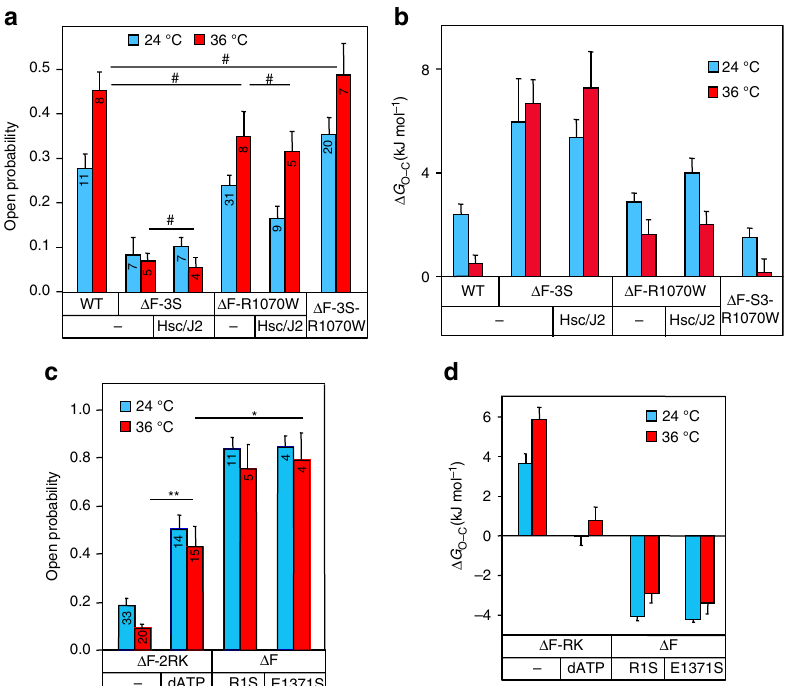
Fig. 7 Chaperoning of Δ F508-CFTR unfolding is altered by second site mutations in the BLM. a , b The in fl uence of second site suppressor mutations (3S, R1070W and 3S + R1070W) and Hsc70/DNAJA2 (Hsc/J2) activity on the P o a and Δ G O – C b of the Δ F508-CFTR-3HA at 24 and 36 °C in BLM. The P o and Δ G – NBD2 dimer was accomplished by R1S, E1371S mutations, or by the O were measured as in Figs. 3 and 4. c , d Stabilization of NBD1 and/or NBD1 inclusion of 2 ʹ -deoxyadenosine 5 ʹ -triphosphate (dATP, 2 mM). The Gibbs free energy of opening was calculated based on the Δ G O – C = − RT(ln K e ) equation. Representative records are shown in Supplementary Fig. 7a, b, d – f. The reconstituted channels were characterized as in Figs. 2 and 4. Data are means ± SEM, n is de fi ned in c . # P ≥ 0.05, * P < 0.05 or ** P < 0.01. The P o values of R1S and E1371S mutants were derived from Veit et al.